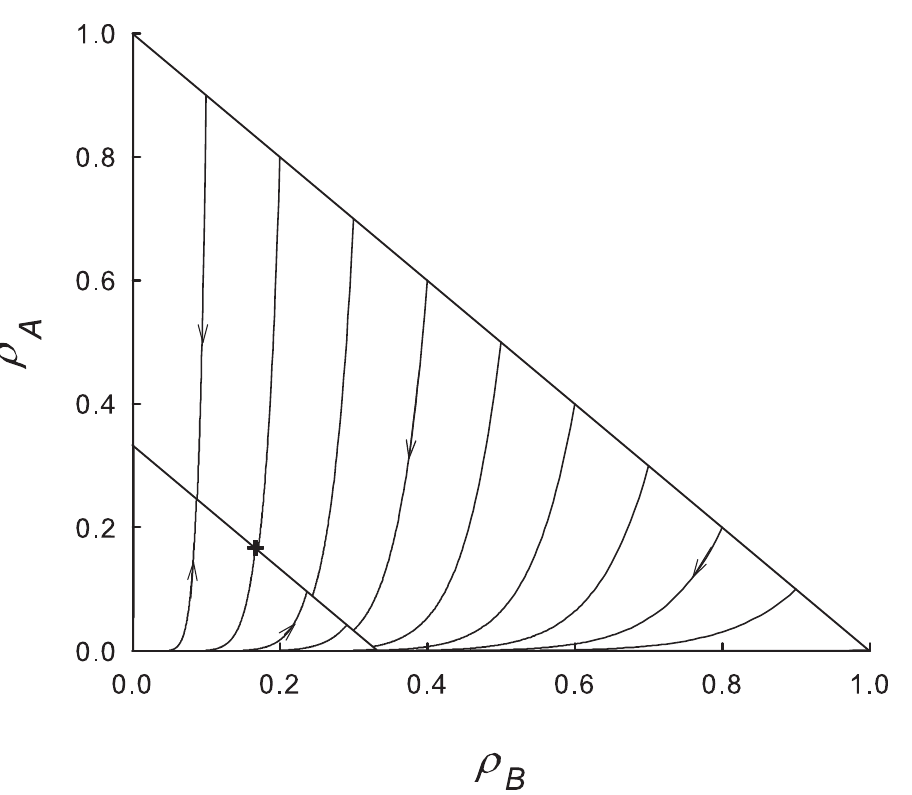
Fig 2. MF equations: Trajectoriesin the ρ B — ρ A plane for λ = 1.5 and α = 0.1. All trajectories terminate on the stationary line, ρ B + ρ A = 1/3. Most of the trajectories originatingbelowthis line terminate with ρ A > ρ B , i.e., to the left of the point (1/6, 1/6) denotedby a + sign.